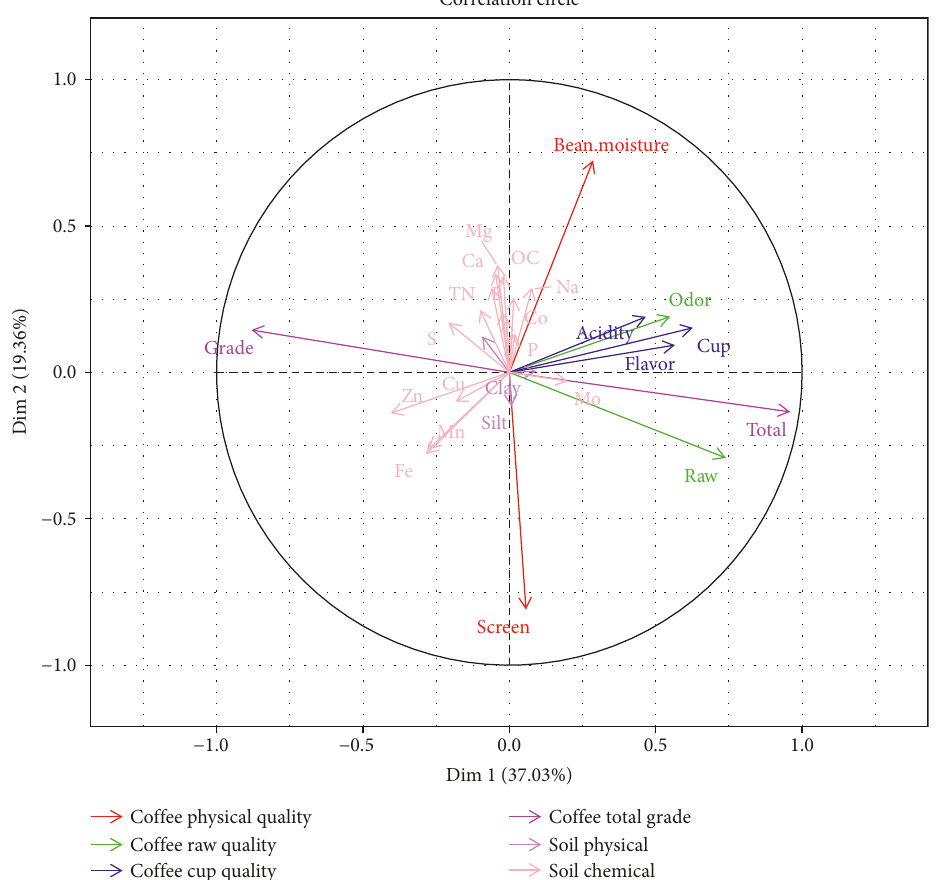
Figure 4: Correlation plot of measured quantitative